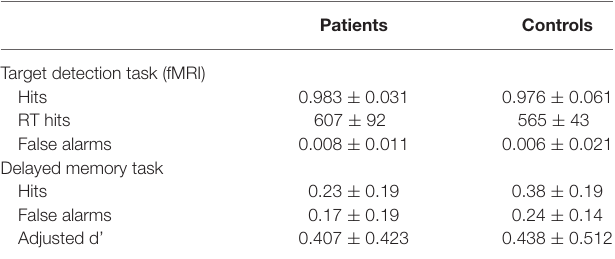
TABLE 2 | Descriptive statistics of the behavioral results